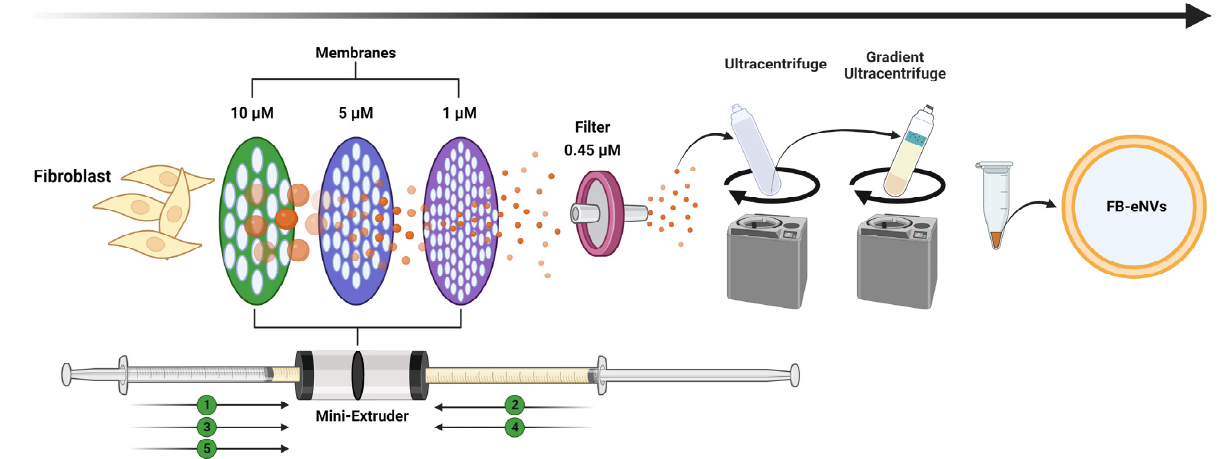
Figure 1. Establishment of engineered nanovesicles of fibroblasts (FB-eNVs). Schematic illustration of the generation and purification of FB-eNVs. The fibroblasts were extruded through 10-, 5-, and 1- µM membranes and subsequently filtered through 0.45-µM filters. The filtered, unpurified samples were ultracentrifuged and purified using OptiPrep density gradient ultracentrifugation. The figure was created using BioRender.com.